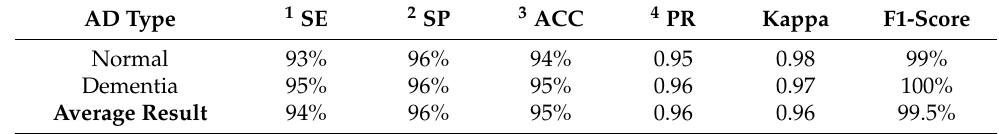
Table 4. Performance evaluation metrics of the implemented CAD-ALZ system on 51,200 samples. AD Type 1 SE 2 SP 3 ACC